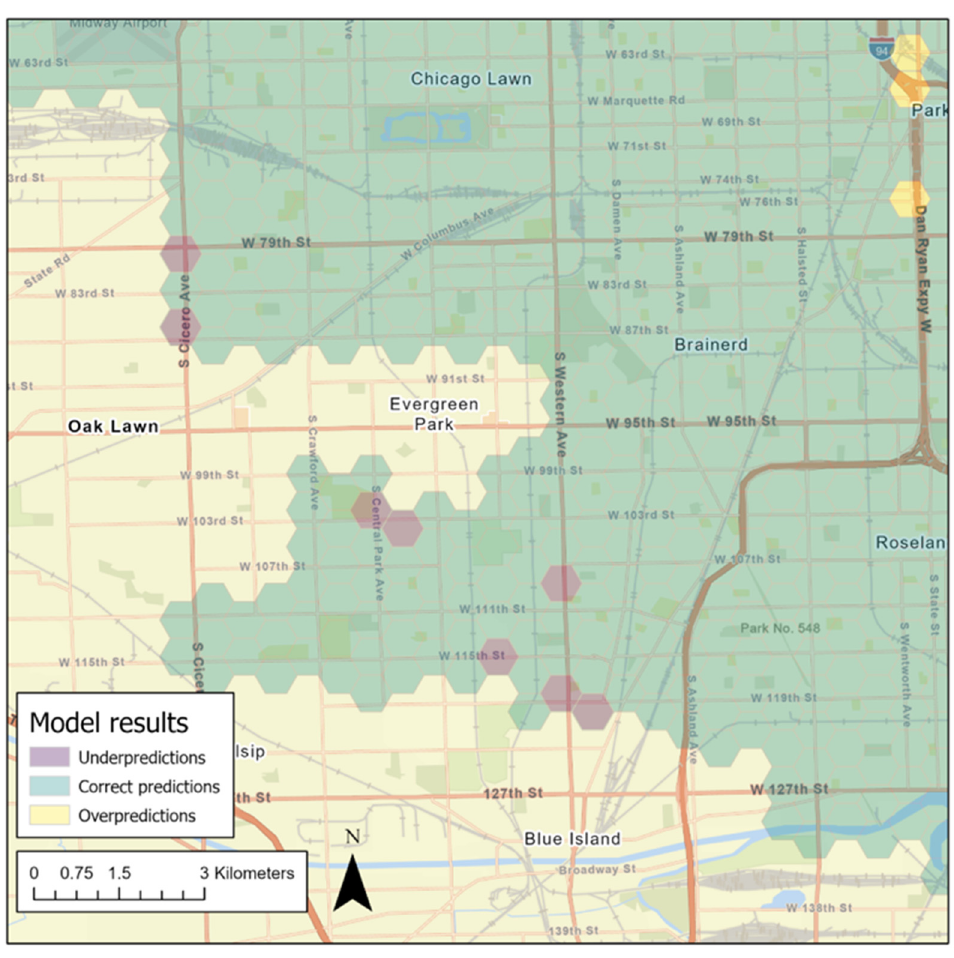
Figure 3. Most of the model underpredictions (areas where the model incorrectly predicted low prostitution arrests) occur in southwestern Chicago. prostitution arrests) occur in southwestern